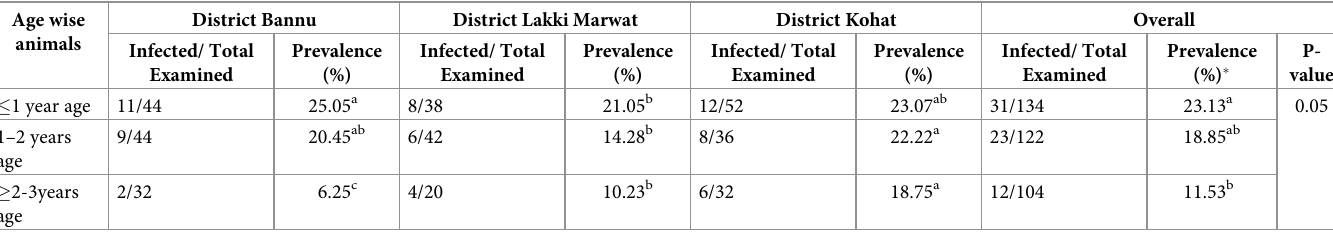
Table 2. Age wise prevalence of Cryptosporidium infection in sheep detected by simple microscopy. Age wise